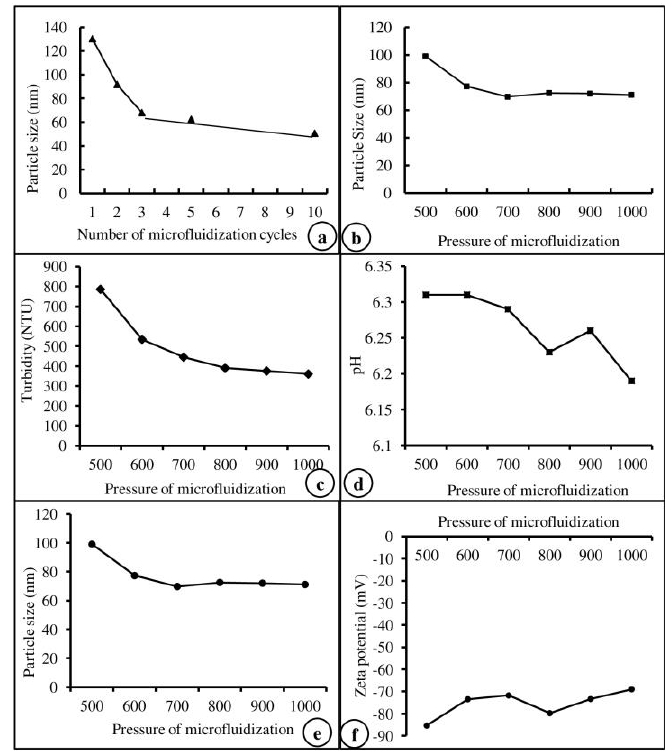
Figure 1. Physiological characteristics of microfluidization cycles ( a ), pressure ( b ), turbidity ( c ), pH ( d ), particle size ( e ), and zeta potential ( f ) of the core material (Lipoid S75).